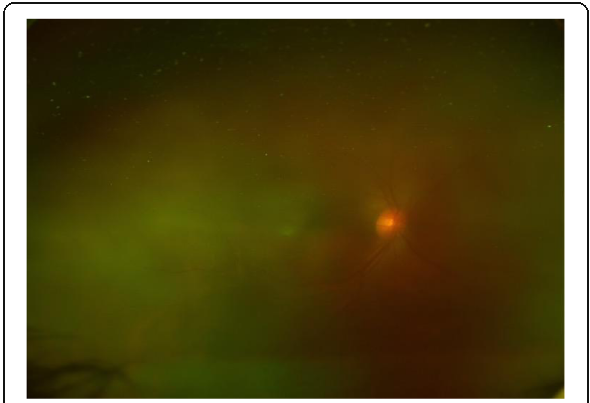
Fig. 2 Ultra-wide-field fundus image of right eye showed almost normal. BCVA was 20/50 of right eye at that time